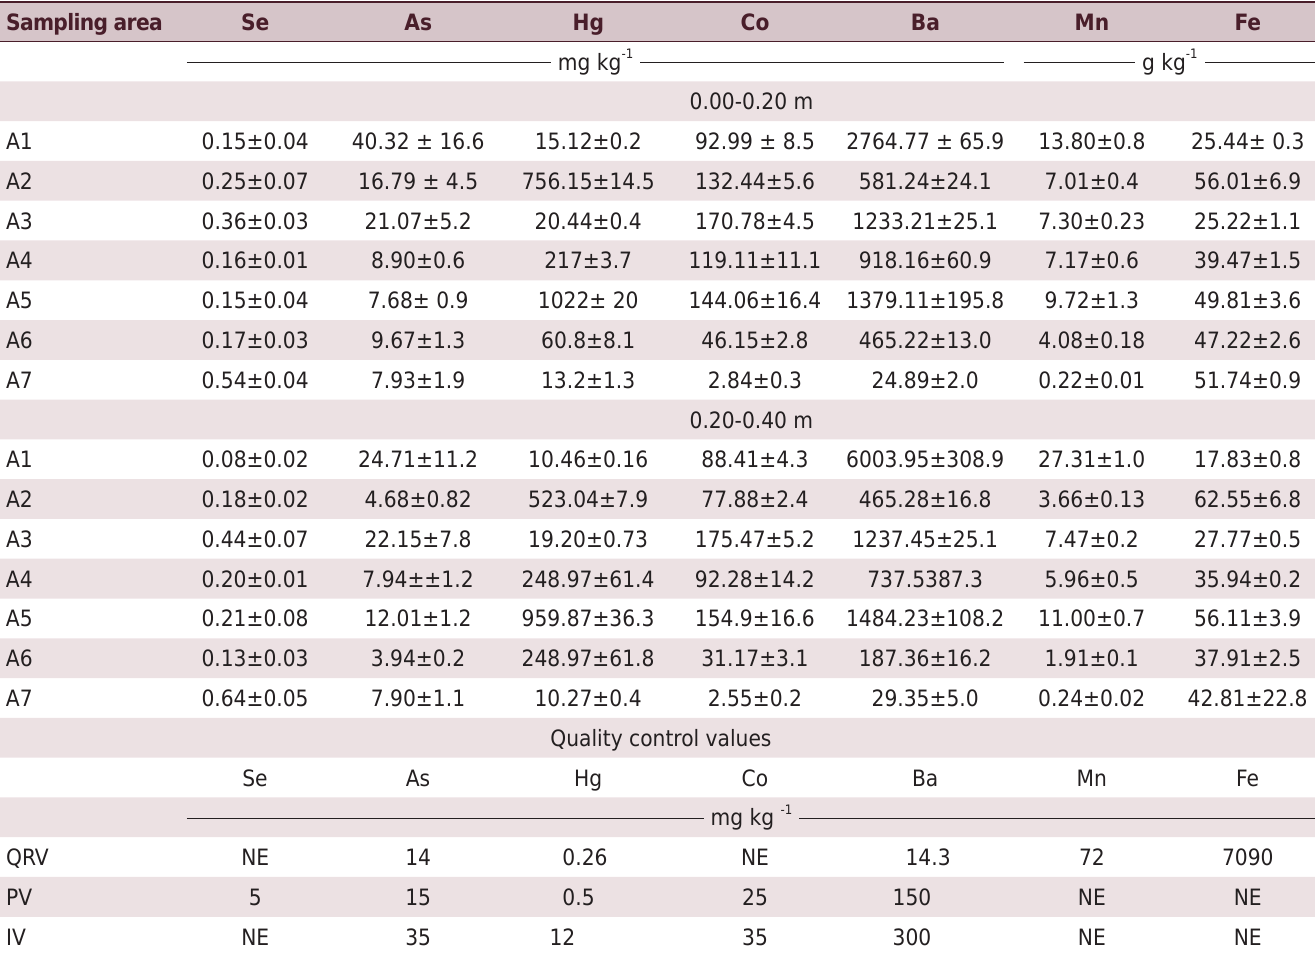
Table 2. Pseudo total contents of potentially toxic elements in soil and sediments for the 0.00-0.20 and 0.20-0.40 m layers from Serra Pelada and quality control values (QCV) Sampling area Se